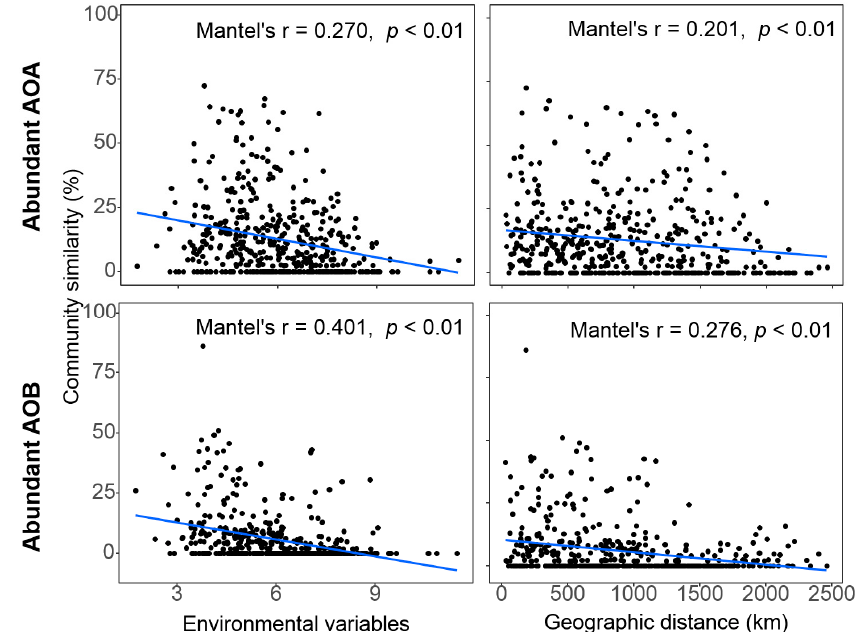
Figure 5. Spearman’s rank correlation between ammonia-oxidizing microbe communities (Bray-Curtis similarity) and the Euclidean distance of environmental factors, geographic distance. The blue lines denote the linear regression across all sampling sites. The Mantel test was used to examine the correlations between the pairwise Bray-Curtis similarity and pairwise differences in environmental variables / geographic distance. All 19 environmental variables were used.